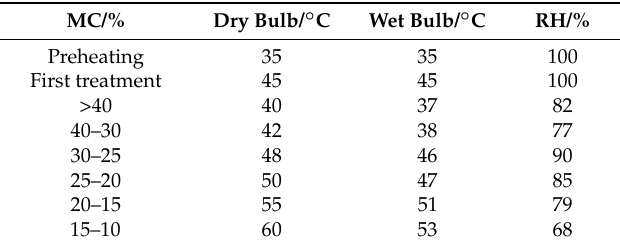
Table 1. Drying schedule of different treated poplar wood. MC: moisture content; RH: relative